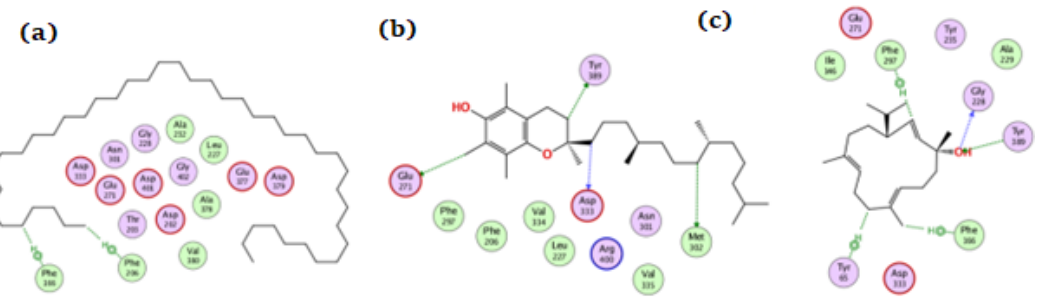
Figure 8. The docking of ( a ) tetratetracontane, ( b ) α -tocopherol, and ( c ) thunbergol on the active site of glucosidase enzyme (PDB code: 3wy2).